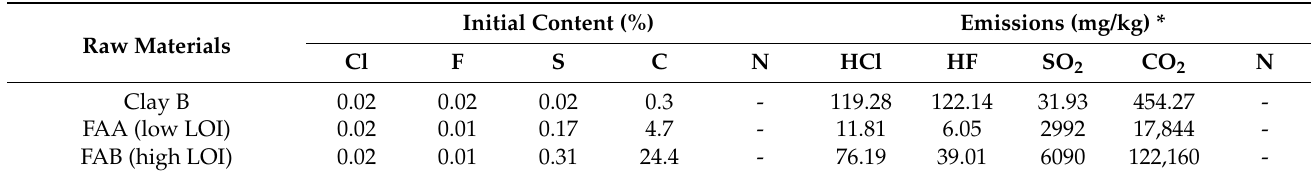
Table 4. Content and pollutants emissions of clay B and fly ashes A and